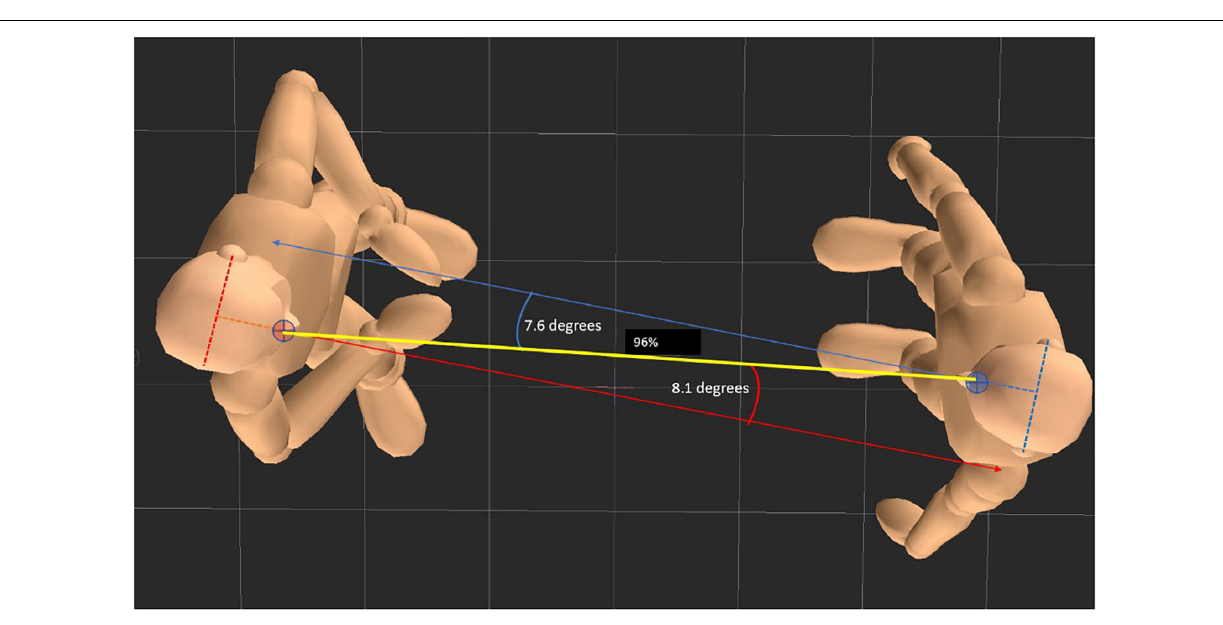
FIGURE 6 | Rationale for measuring rotational head orientation and interpersonal proximity. Invisible virtual markers between the characters’ eyes were used as anchor for distance measurement and as references for the assessment of rotational deviations from the direct line of view. The angle was calculated as orthogonal to the line between two virtual ear markers projected onto the x/z plane. Distance was calibrated as percentage of both partners’ arm